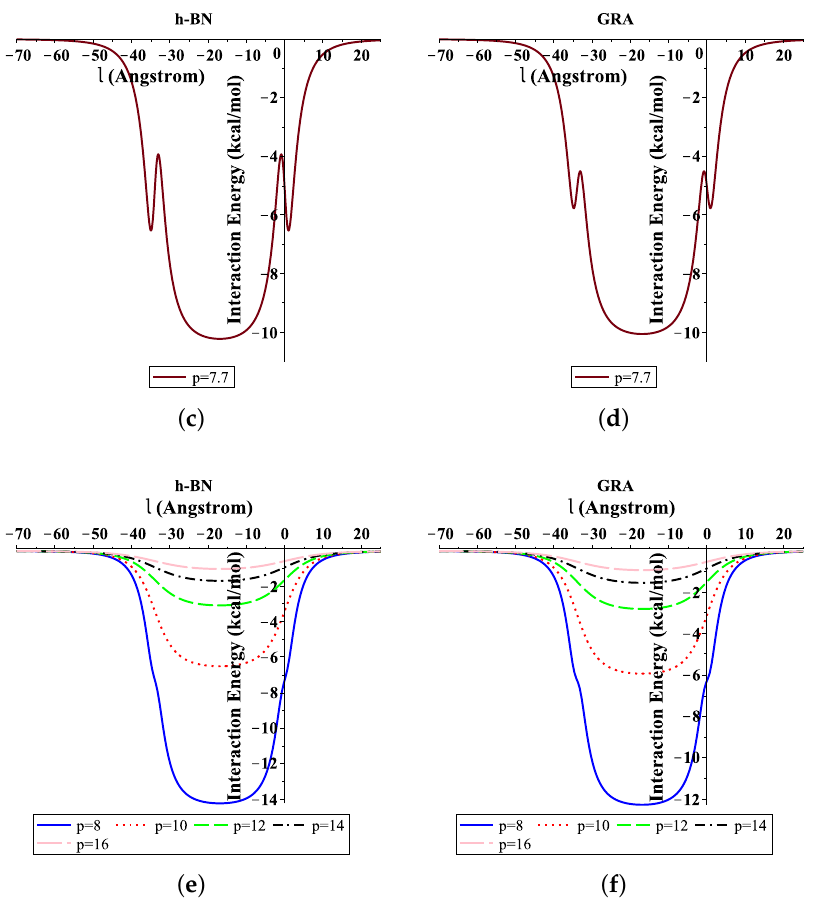
Figure 4. Interaction energies of ssDNA with pores of various values of p , with respect to the perpendicular distance l . ( a ) ssDNA-BN pore, ( b ) ssDNA-GRA pore, ( c ) ssDNA-BN pore, ( d ) ssDNA- GRA pore, ( e ) ssDNA-BN pore, ( f ) ssDNA-GRA